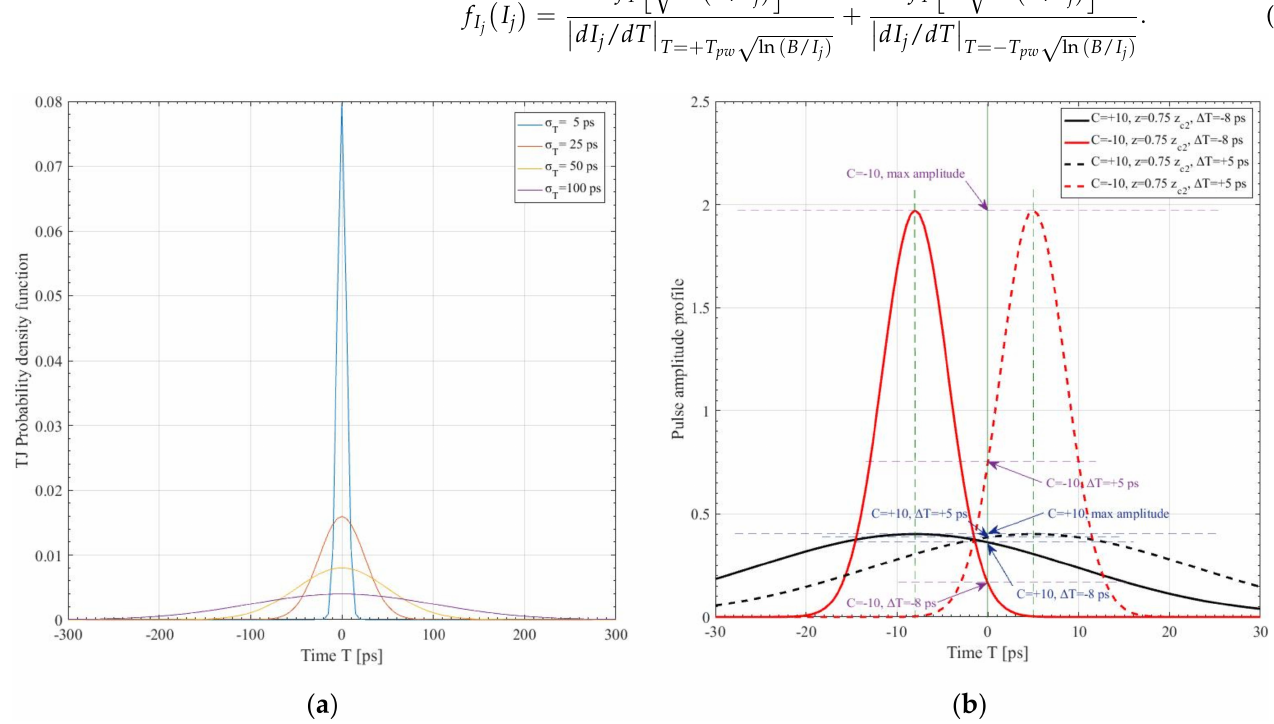
Figure 3. ( a ) Symmetric TJ PDF curves as a function of time T for various TJ strength parameter values. The corresponding timeslot of 100 Mbps is 10 ns, the edges of which are at T 1 = +5 ns and T 2 = − 5 ns. ( b ) Time-jittered pulses for two random jitters, ∆ T , and opposite chirp parameters. In any case, the pulse amplitude, received at instant T = 0, is much lower than the corresponding maximum pulse amplitude, as detected at z = 0.75 z c2